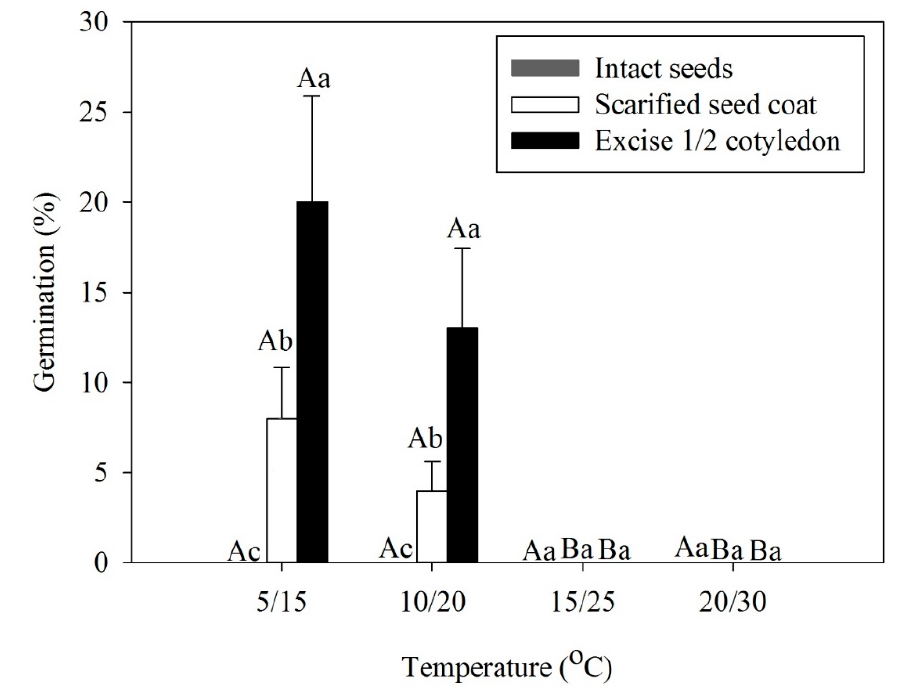
Figure 2. Effects of scarification and partial removal of the cotyledon on germination of Sorbus alnifolia (Siebold & Zucc.) K.Koch seeds. Error bars are mean ± se. Different uppercase letters indicate significant differences among temperatures in the same treatment, and different lowercase letters indicate significant differences among seeds of intact, scarified seed coat, and seeds with half of cotyledon excised at the same temperature ( p <